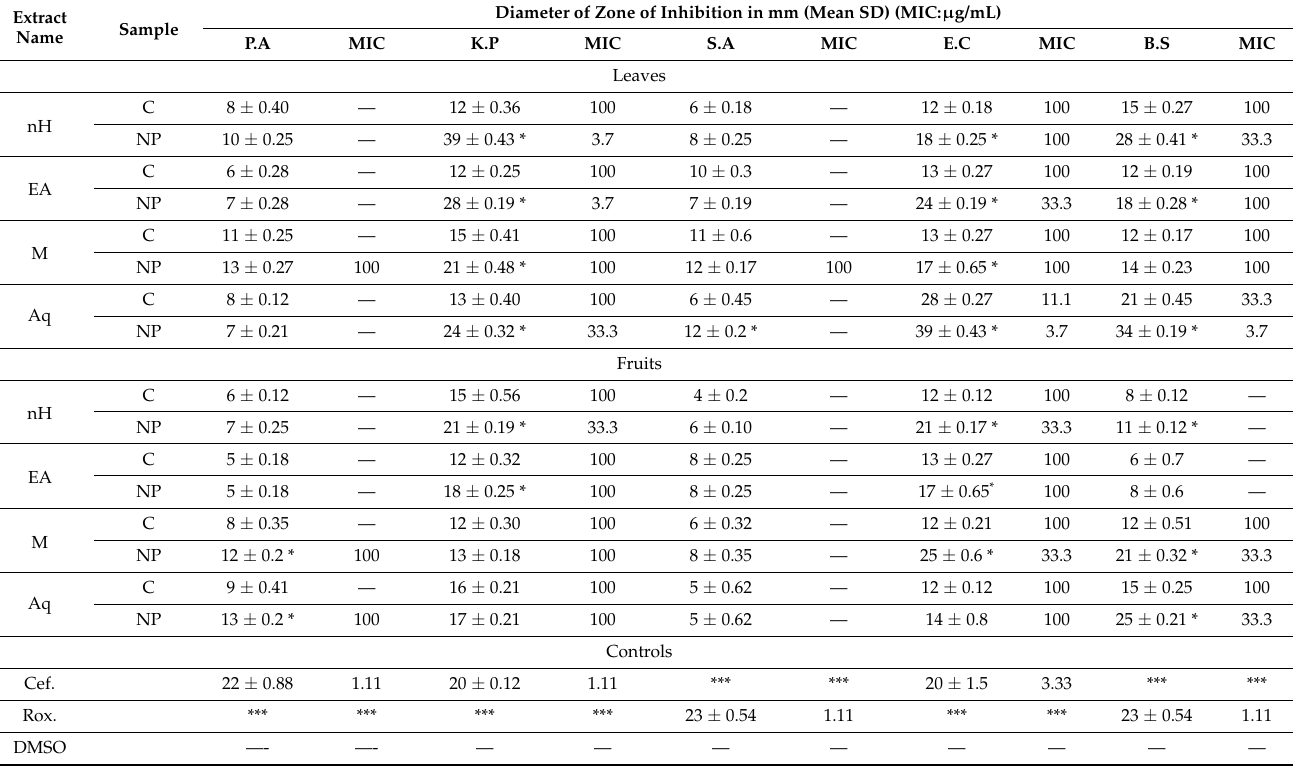
Table 2. Antibacterial activity of crude extracts and nanoparticles of leaves and fruits of C. colocynthis